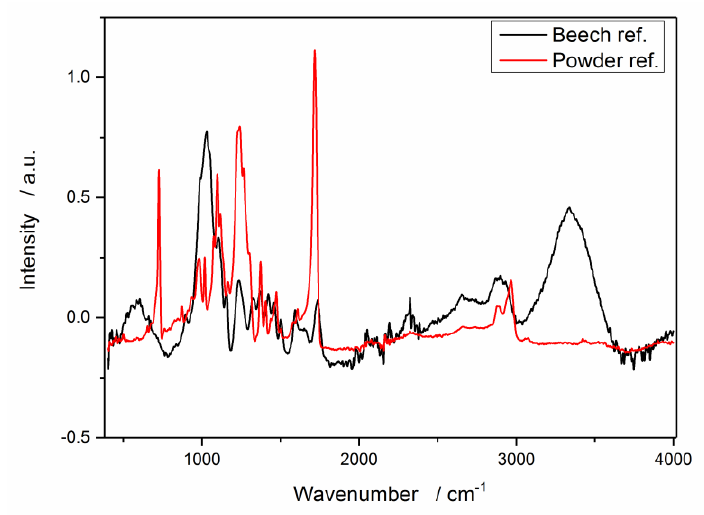
Figure 5. FTIR spectra of uncoated European beech and the powder reference.